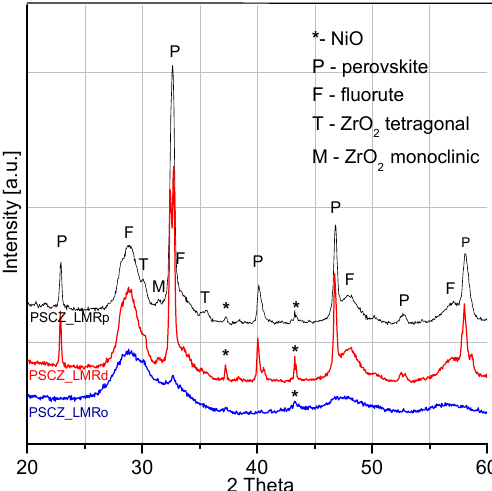
Figure 1. The XRD patterns of as-prepared NiPSCZ_LMR